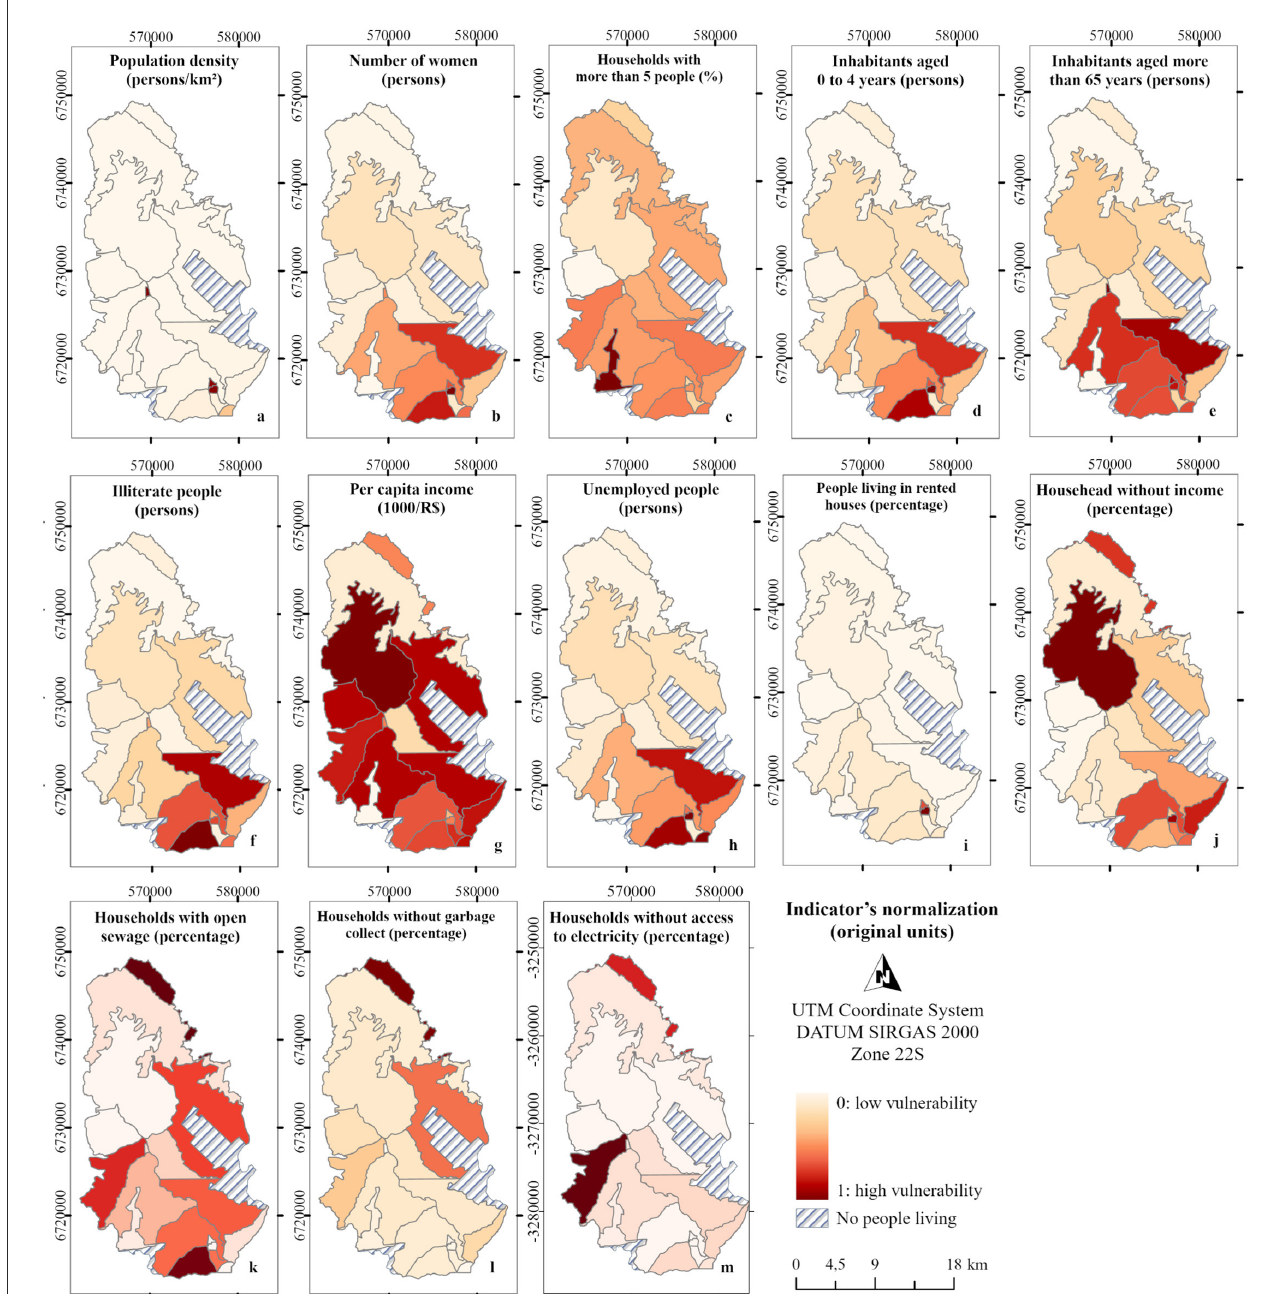
FIGURE4 Maps with the normalized flood vulnerability indicators. The original units used to represent the indicator are shown in